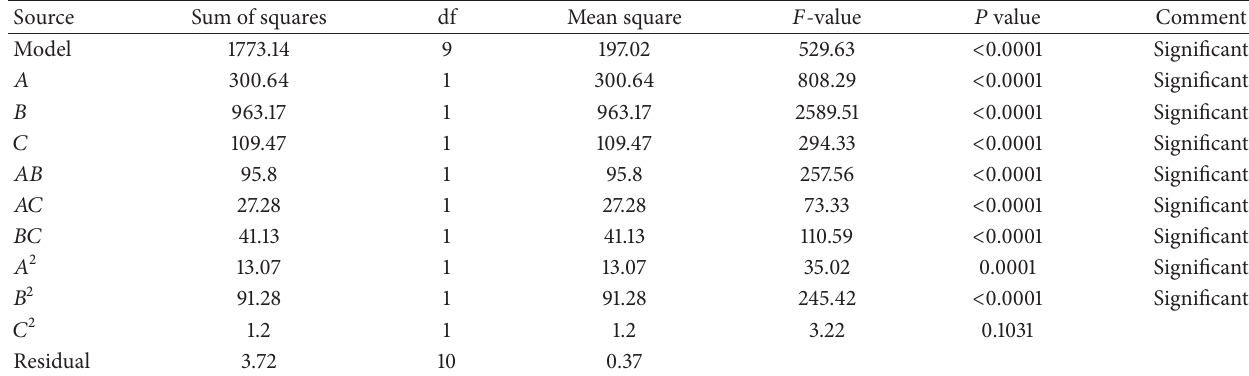
Table 4: ANOVA table for removal efficiency (model for response 𝑌 1 ).